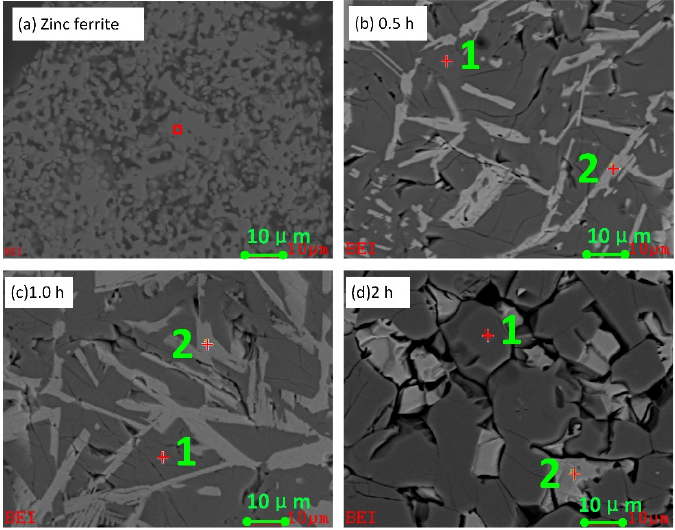
Table 4. EDS analysis of the roasted product with the roasting time of 2 h.